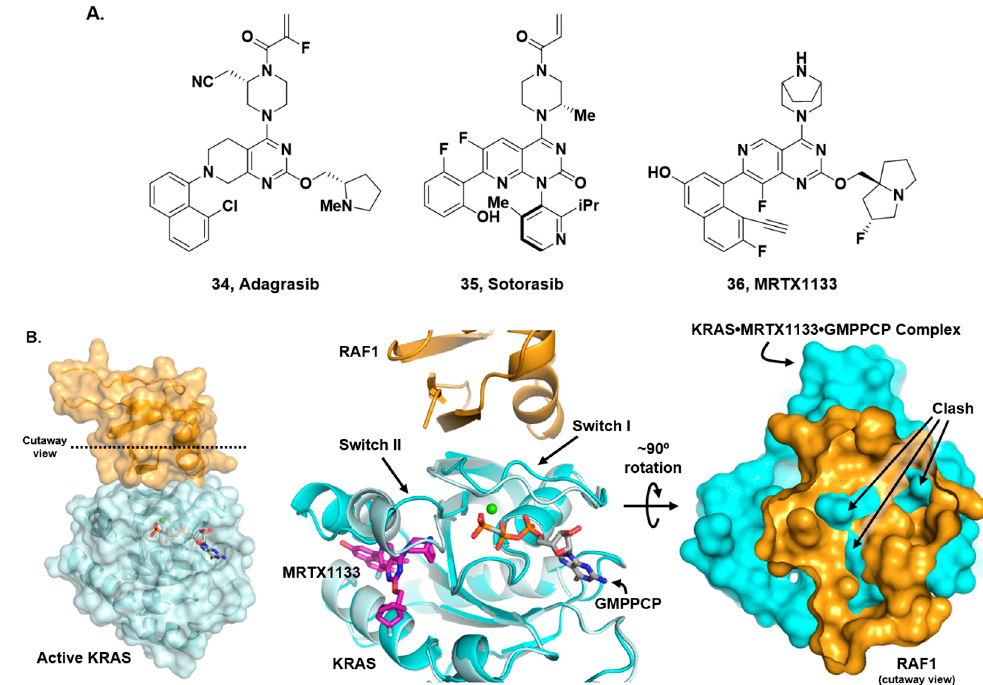
Figure 11. ( A ) Structures of adagrasib, sotorasib and MRTX1133 ( 34 – 36 ). ( B ) Left: X-ray crystal structure (PDB: 6VJJ) of the RAS binding domain of RAF1 (orange) complexed with GMPPNP-KRAS (light blue) where GMPPNP is an analog of GTP. Middle: KRAS G12D -MRTX1133-GMPPCP (PDB: 7T47, cyan ribbon) superposed with the KRAS-GMPPNP-RAF1 complex (light blue and orange ribbons) where GMPPCP is also an analog of GTP. Right: KRAS-RAF1 complex rotated 90° and cutting away the RAF1 surface reveals clashes with the KRAS G12D -MRTX1133-GMPPCP surface in cyan.